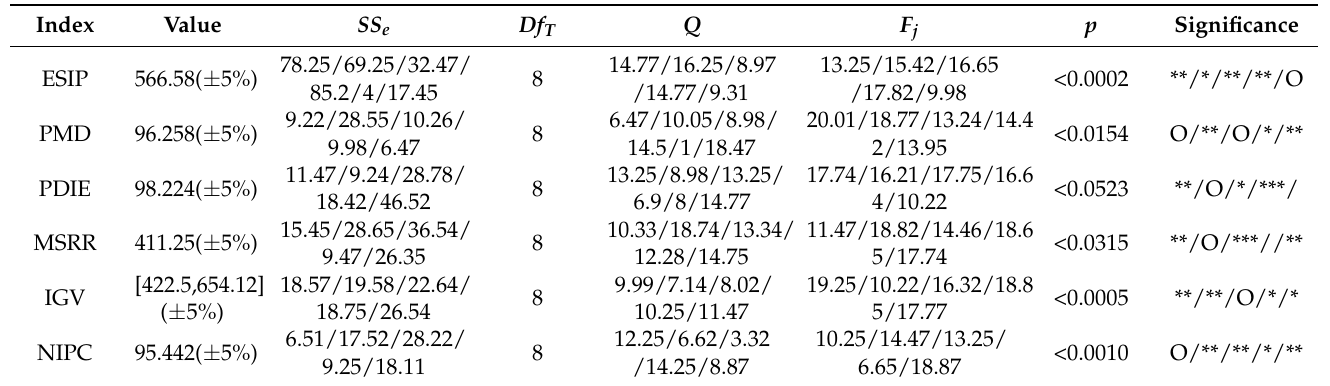
Table 9. Variance analysis of sprinkler drip infiltration quality indices using F-ratio